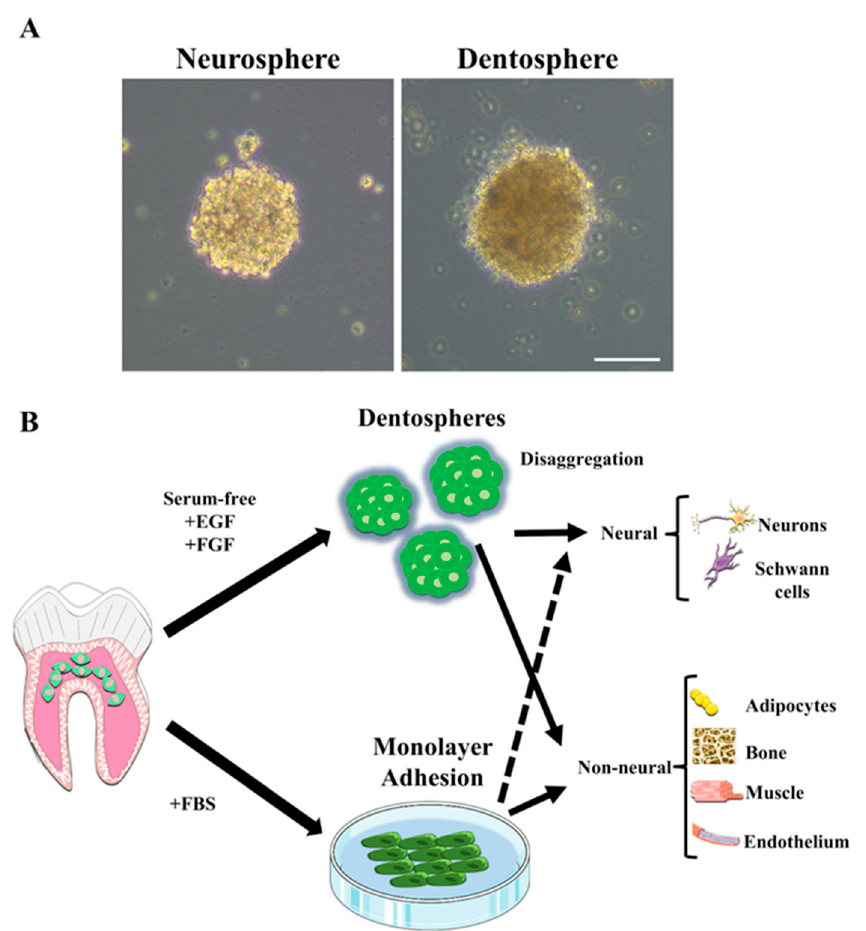
Figure 3. Culture protocols to induce neural differentiation of hDPSCs. ( A ) When grown in the same serum ‐ free media, hDPSCs form pulp dentospheres which are morphologically and functionally similar to brain neurospheres. ( B ) Like neurospheres, dentospheres can be disaggregated to generate neuronal and glial marker expressing cells in the presence of neural induction media. The same hDPSCs in the presence of fetal serum (FBS) differentiate preferentially to non ‐ neural cell lineages. However, it is also possible to generate non ‐ neural cells from pulp dentospheres in serum ‐ free media, and also to induce a neural ‐ like differentiation from hDPSCs when these are switched from serum ‐ containing to serum ‐ free neural induction media.